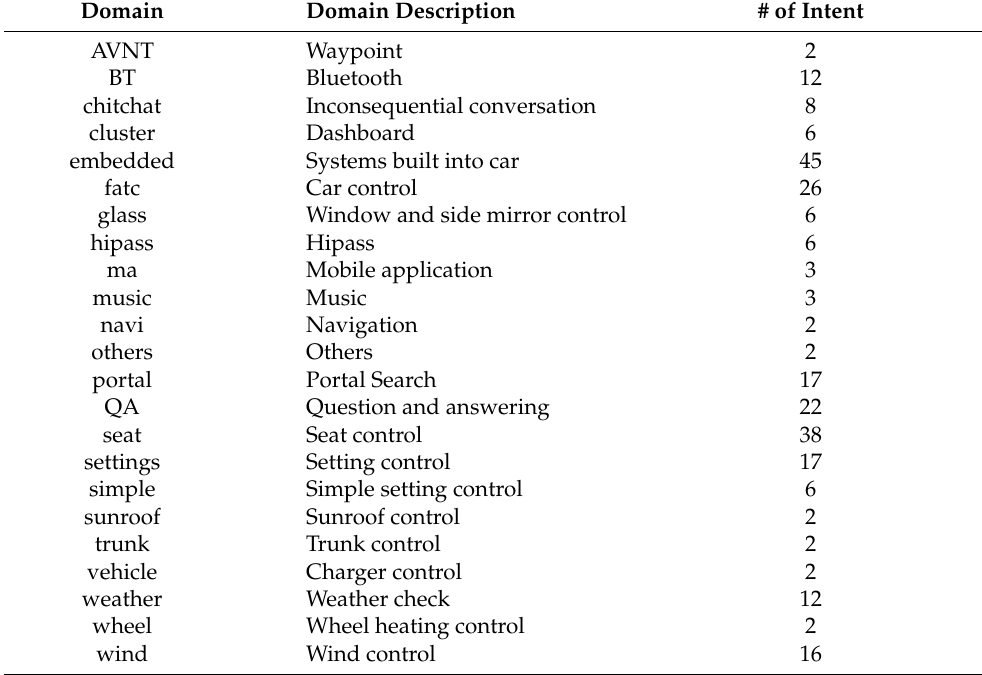
Table 2. Statistics and description of each domain. The number of intents that belong to the domain is also listed.